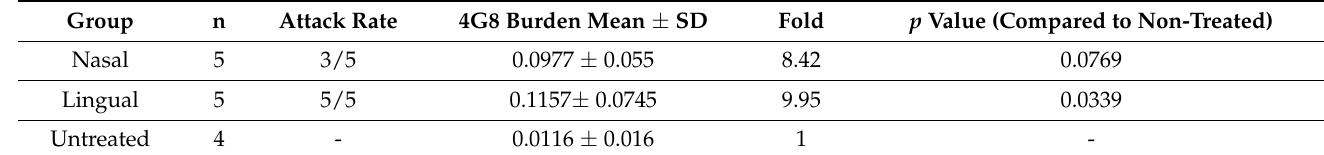
Table 1. Attack rate and brain amyloidosis induced by extra-nasal and intra-lingual administration of A β seeds in Tg2576 mice. Statistical analyses were performed using independent samples t -test (* p < 0.05).